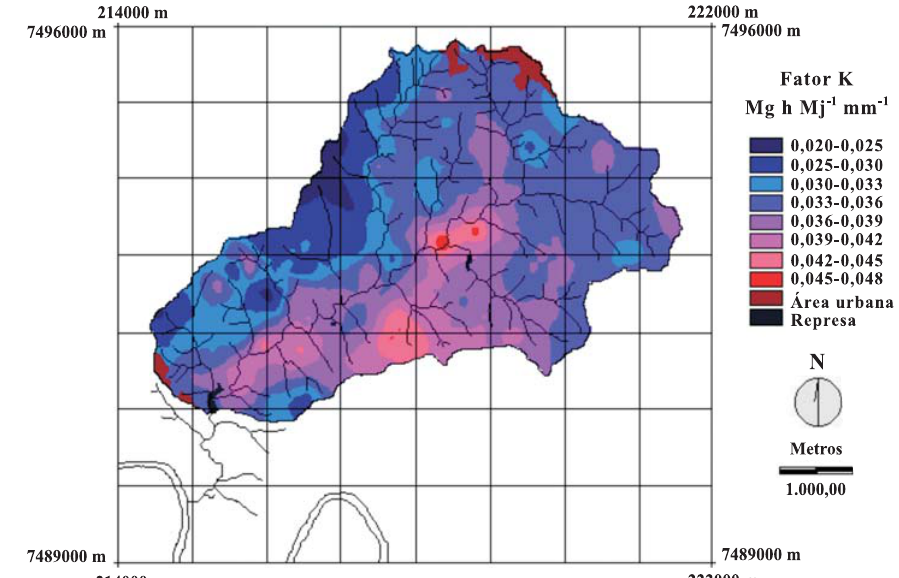
Figura 5. Mapa do fator K para a área de